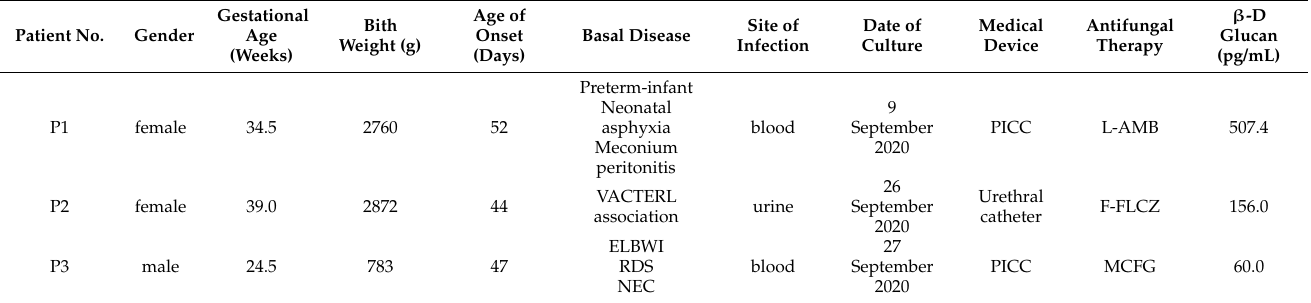
Table 1. The clinical characteristics of the 3 patients. PICC: peripherally inserted central catheter; ELBWI: extremely low birth weight infant; RDS: respiratory distress syndrome; NEC: necrotizing enterocolitis; L-AMB: liposomal amphotericin B; F-FLCZ: fosfluconazole; and MCFG: micafungin.